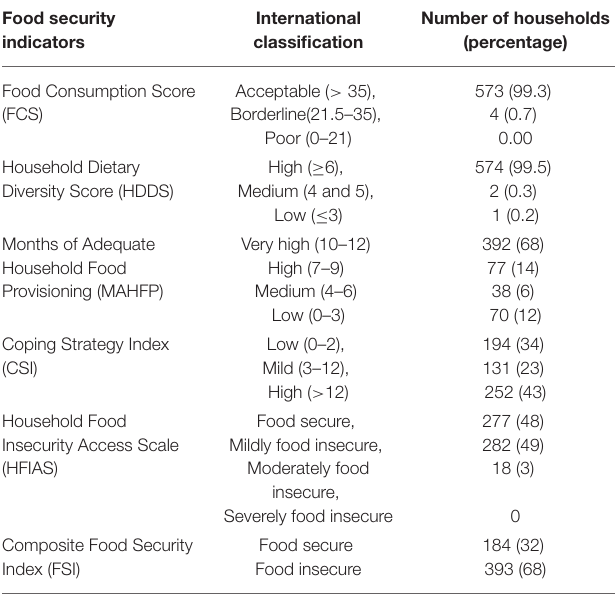
TABLE 5 | Food security classification of households based on the five food security indicators and the food security index. Food security